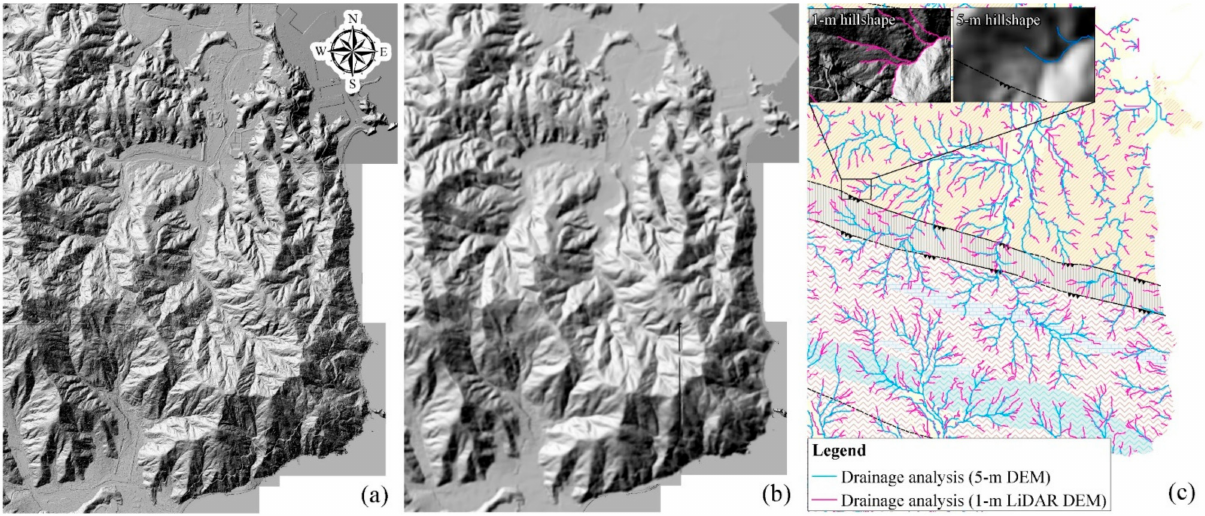
Figure 4. Hillshade maps (sunshine direction 270 ◦ ) generated using 1 m- ( a ) and 5 m- ( b ) resolution DEMs and associated results of drainage analyses ( c ). Dark blue and purple lines are lines of drainage obtained by analyzing 5 m- and 1 m- resolution DEMs,